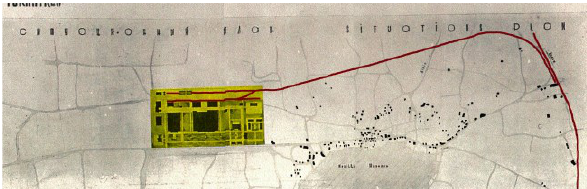
Figure 1. The Sümerbank Nazilli Basma Factory 1934, the original plan drawing, Factory